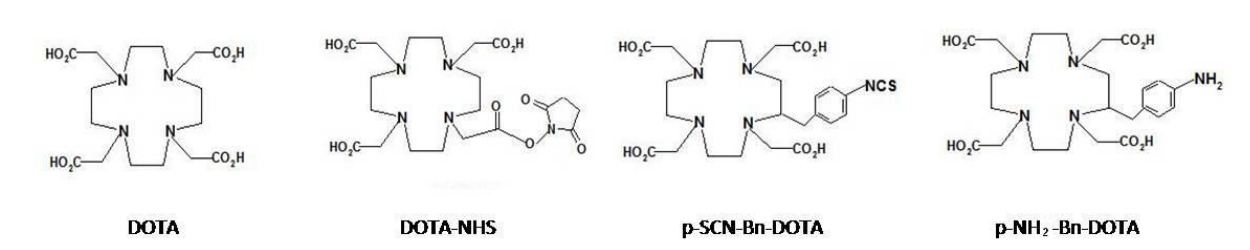
Figure 4. DOTA and three bifunctional DOTA